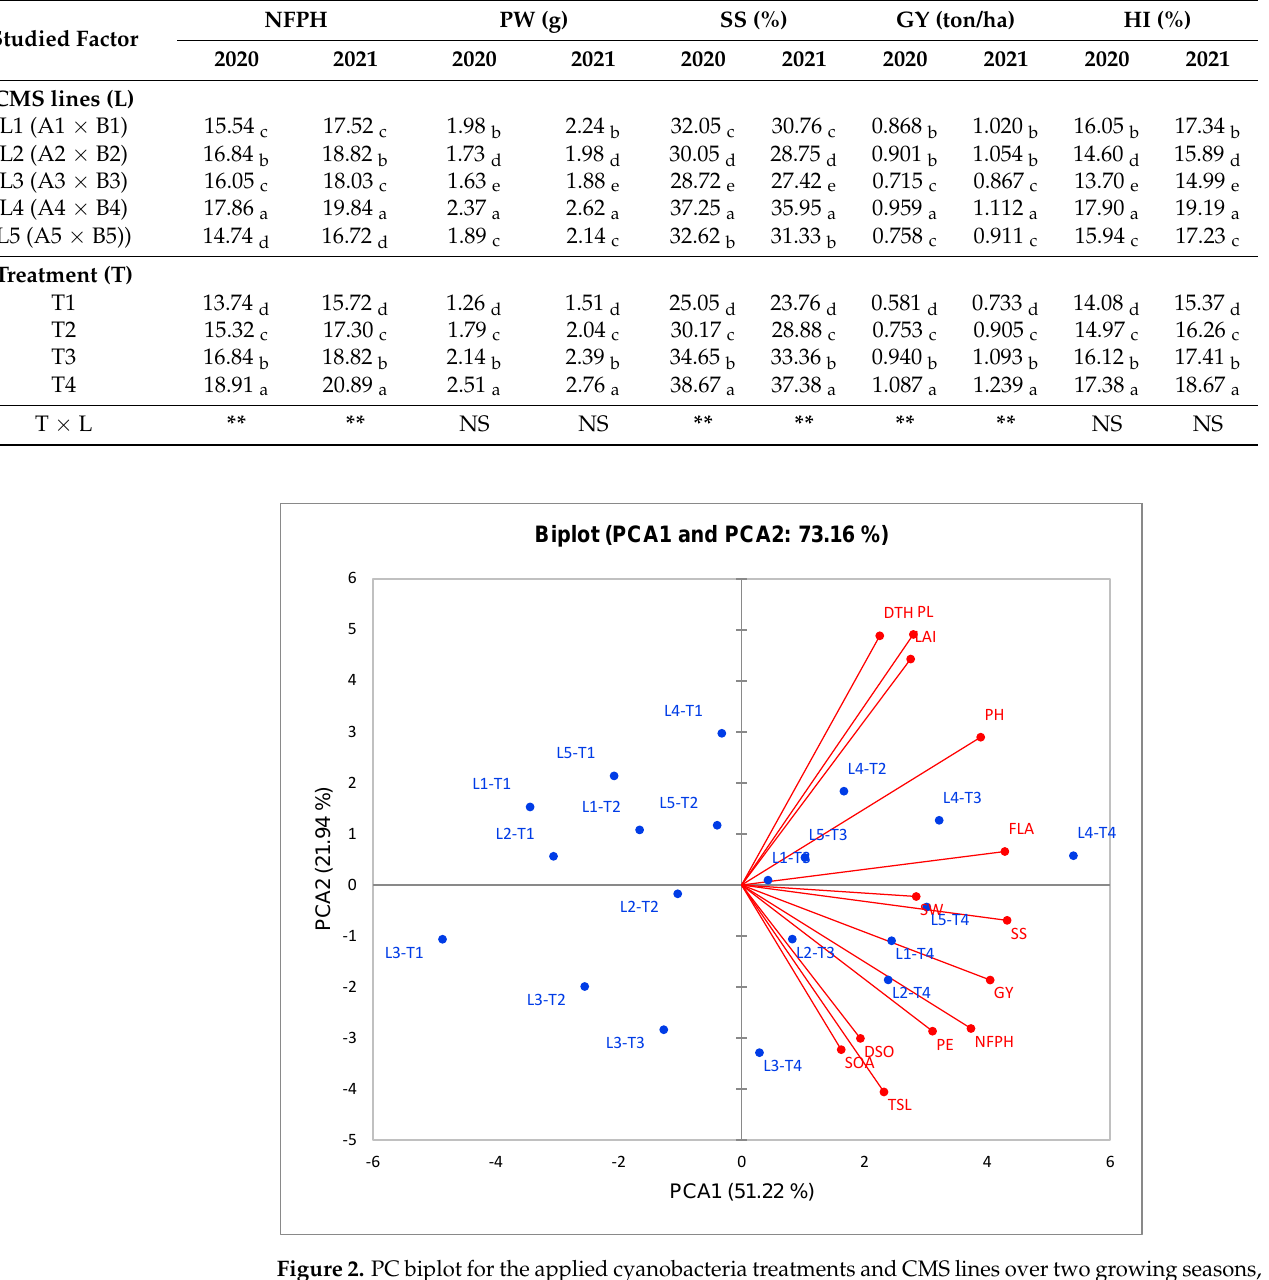
Table 5. The impact of cyanobacteria on the number of fertile panicles per hill (NFPH), panicle weight (PW), seed set (SS), and grain yield (GY) of CMS lines. The table represents the mean performance of CMS line yield-related traits under all treatments (upper part) and the mean performance of treatments in all CMS lines (down part) regarding yield-related traits. T1: untreated control, T2: A. Oryzae , T3: N. muscorum , T4: the combination between T2 and T3. Different lowercase letters within a column indicate a significant difference among the CMS lines under each treatment at p < 0.05. ** = highly significant, NS = not significant. T × L = interaction between treatments and CMS lines.